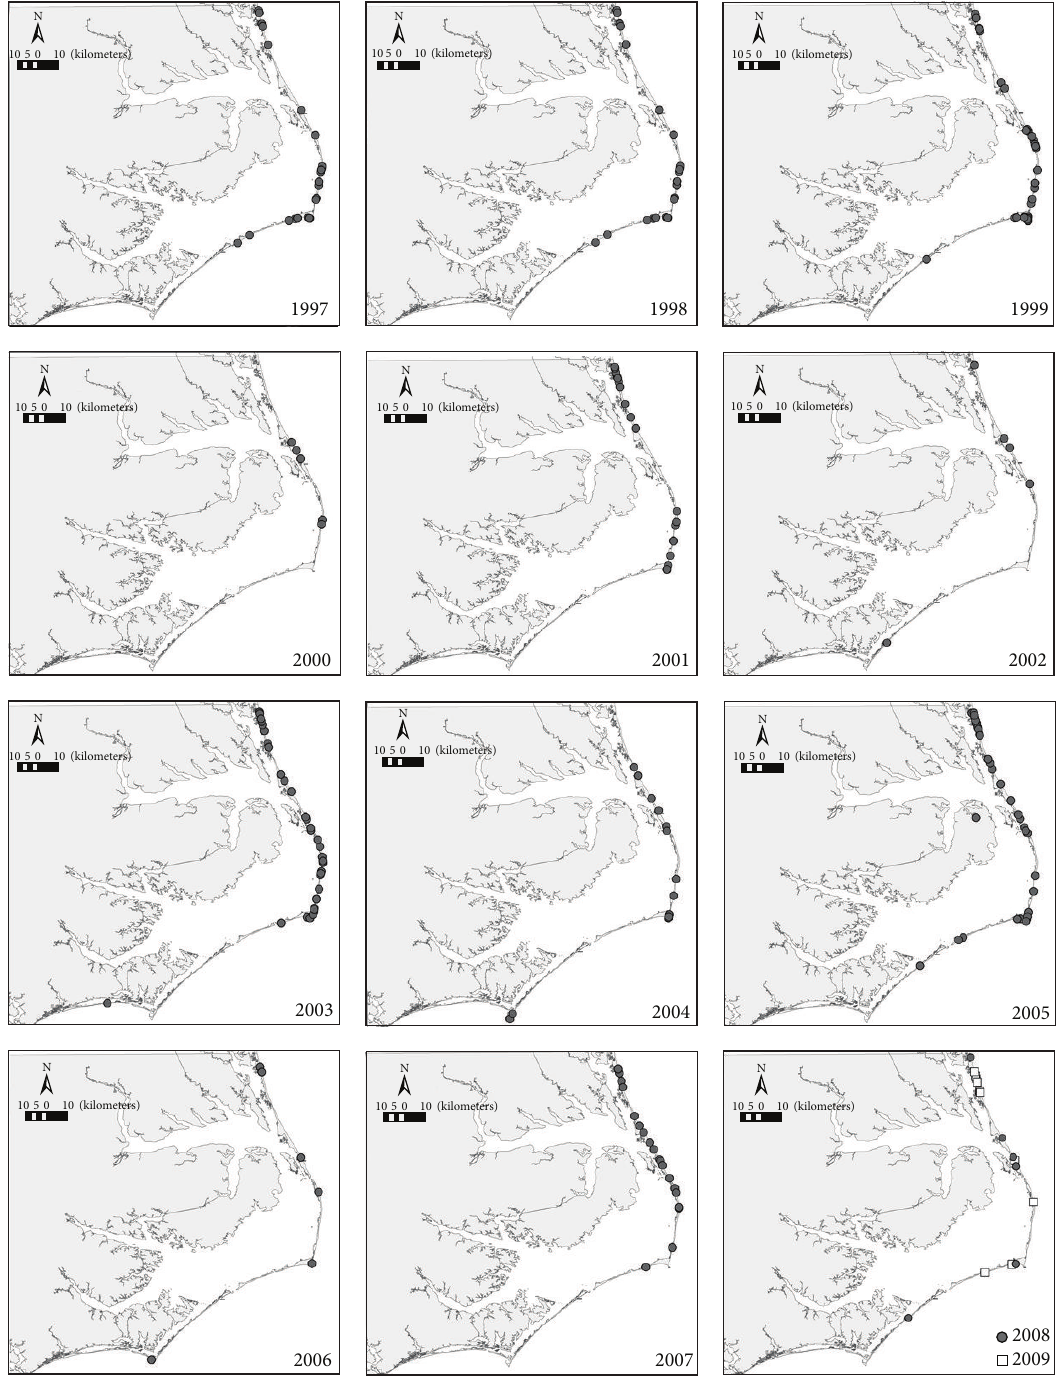
Figure 4: Annual harbor porpoise strandings in North Carolina, 1997–2009. In addition, in 2009 one stranding was recovered in Topsail Beach (see Figure